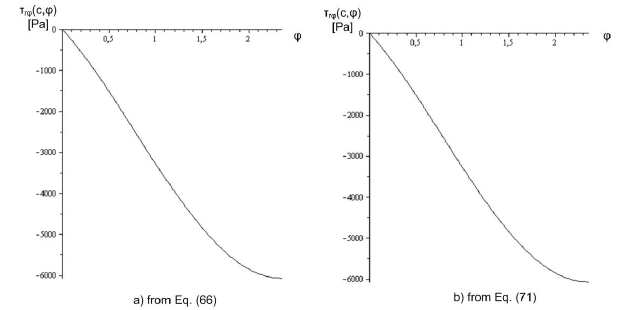
Figure 13: Plots of σ φ for Example 2.